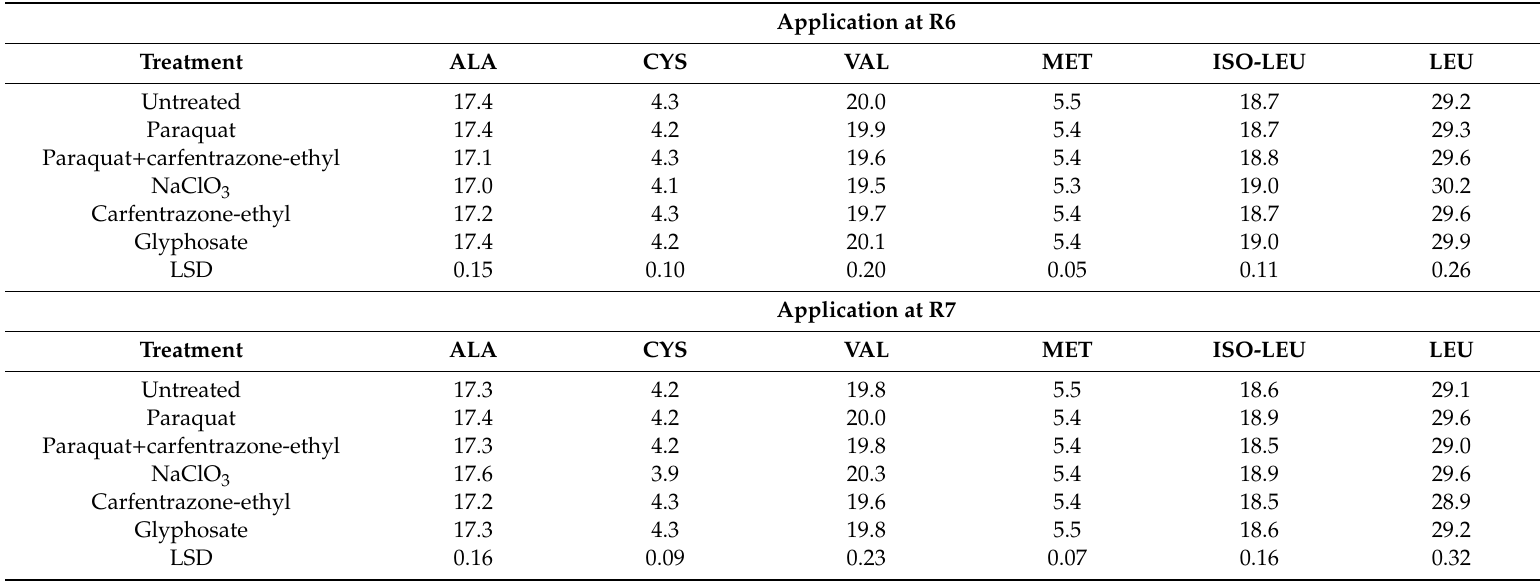
Table 6. E ff ects a of harvest aids (treatments: paraquat, paraquat + carfentrazone-ethyl, carfentrazone-ethyl, NaClO 3 , glyphosate) on the seed amino acids alanine (ALA), cysteine (CYS), valine (VAL), methionine (MET), iso-leucine (ISO-LEU), and leucine (LEU) (mg g − 1 ) across two years. Untreated plants were used as the control. Harvest aids were applied at growth stages R6 and R7. The experiment was conducted in 2012 and 2013 in Stoneville,